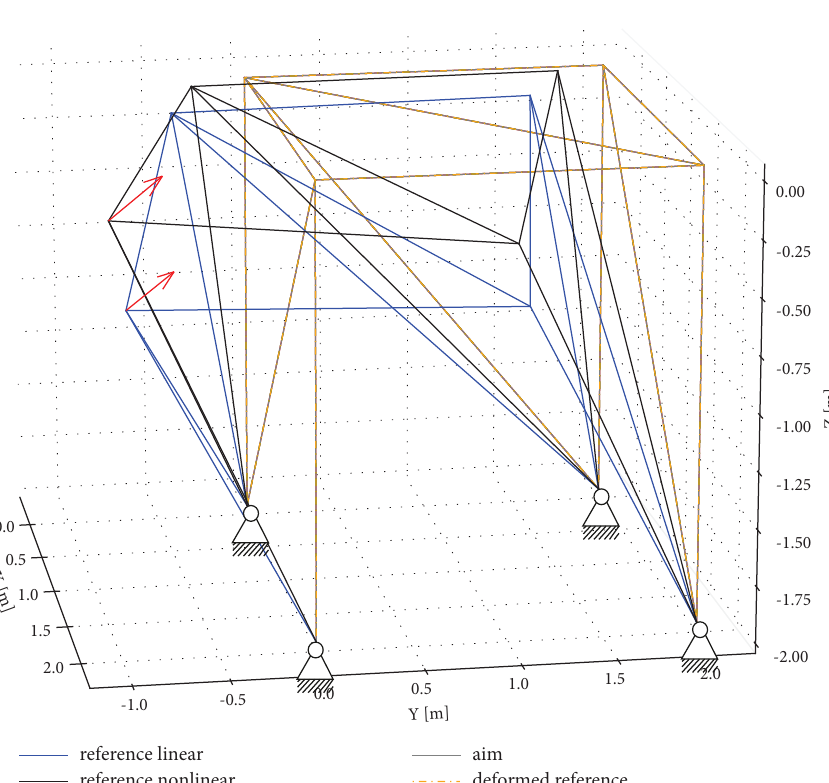
Figure 11: Unknown and known confguration of a three-dimensional frame structure. Te red arrow demonstrates the force vector [ 300 , 300 , 300 ] N